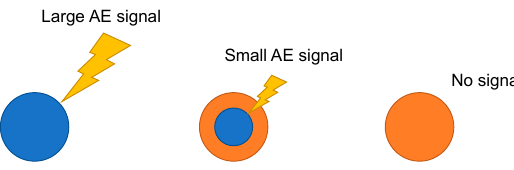
Figure 4. Model of AE signal generation.